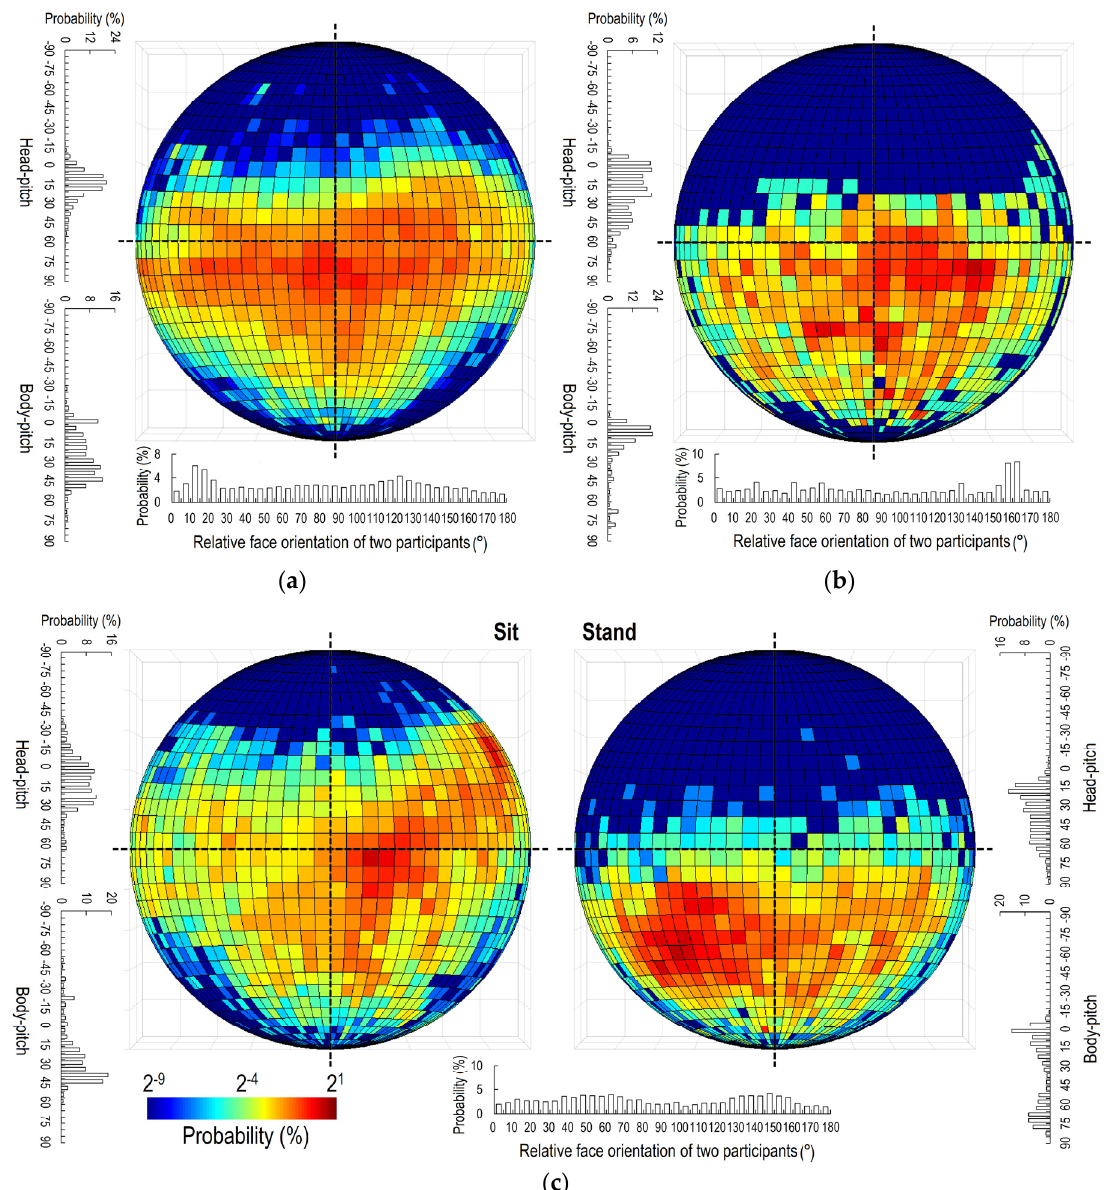
Figure 9. Head and body motions during close contact by posture of the two students: ( a ) Sitting-sitting; ( b ) Standing-standing; ( c ) Sitting-standing. (The circle shows the face orientation of the student; see Figure 4a).